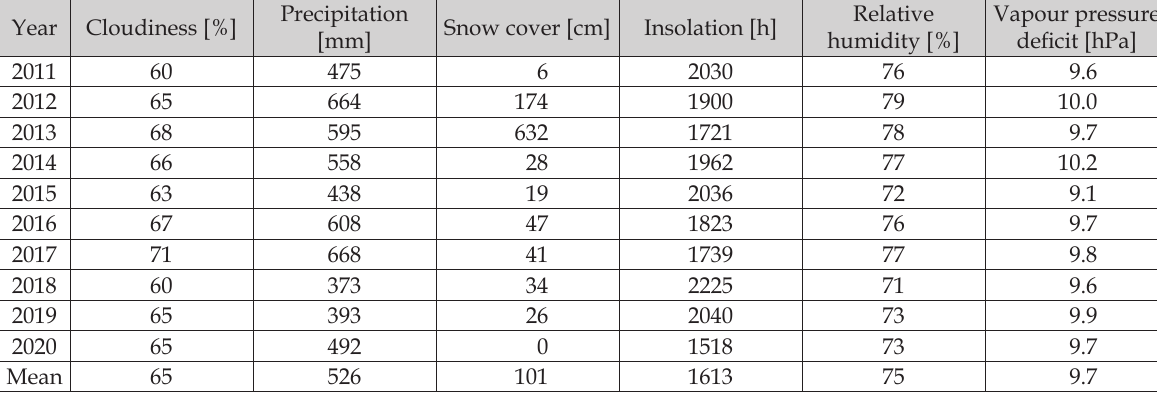
Table 1. The average annual values of chosen meteorological elements in Poznań in years 2011–2020.